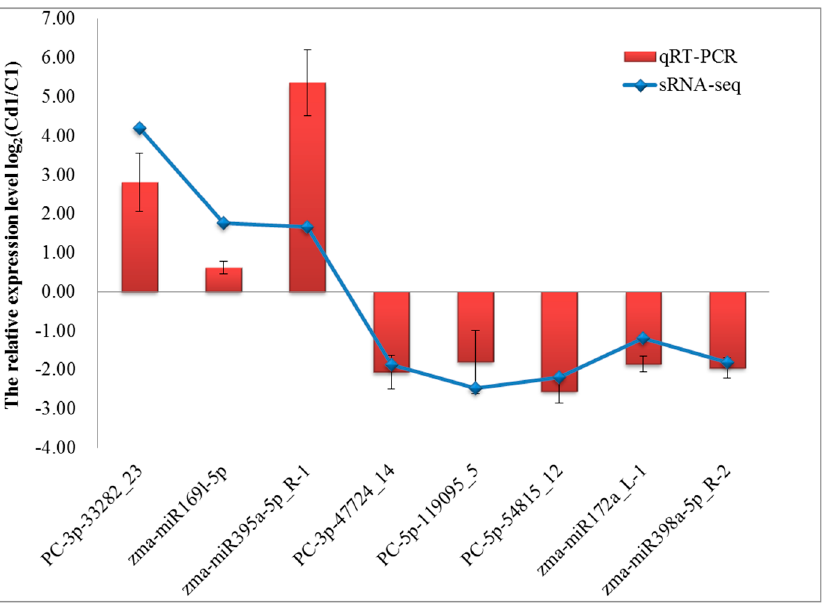
Figure 1. Validation and comparison of the relative expression pattern of the selected eight small RNAs (sRNAs) between qRT–PCR and high-throughput small RNA sequencing.